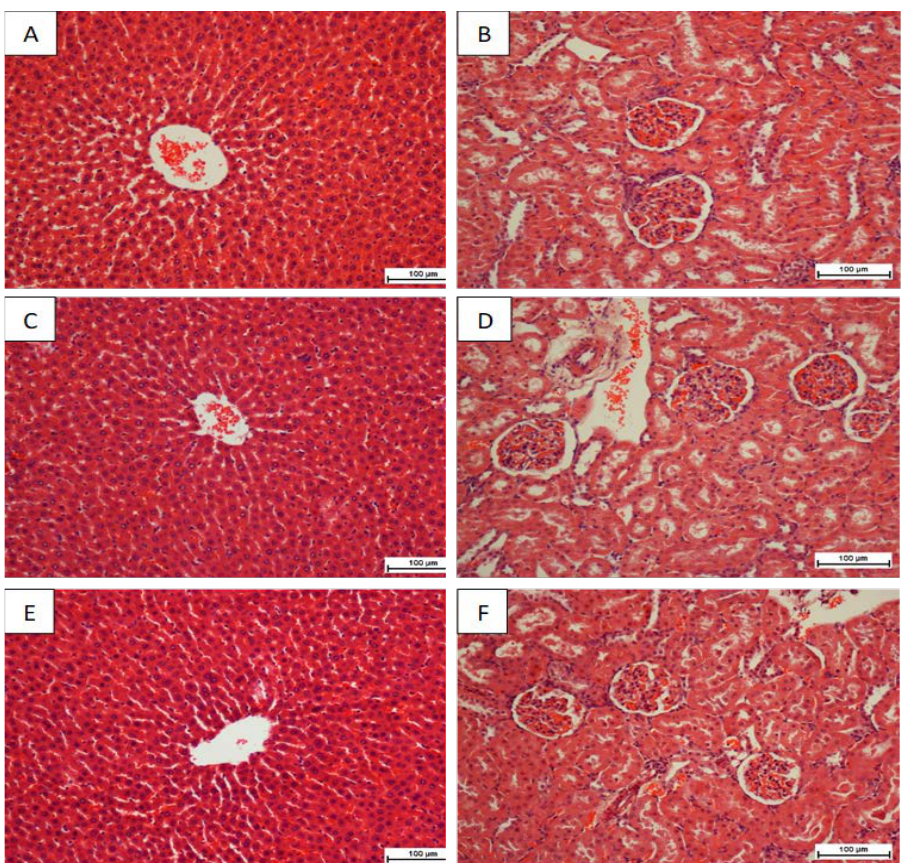
Figure 1. Effect of A. muricata extract on histological sections of the liver ( 1st column ) and kidney ( 2nd column ) from acute toxicity test in rats. ( A , B ) Normal control group, ( C , D ) rats fed with 2 g/kg